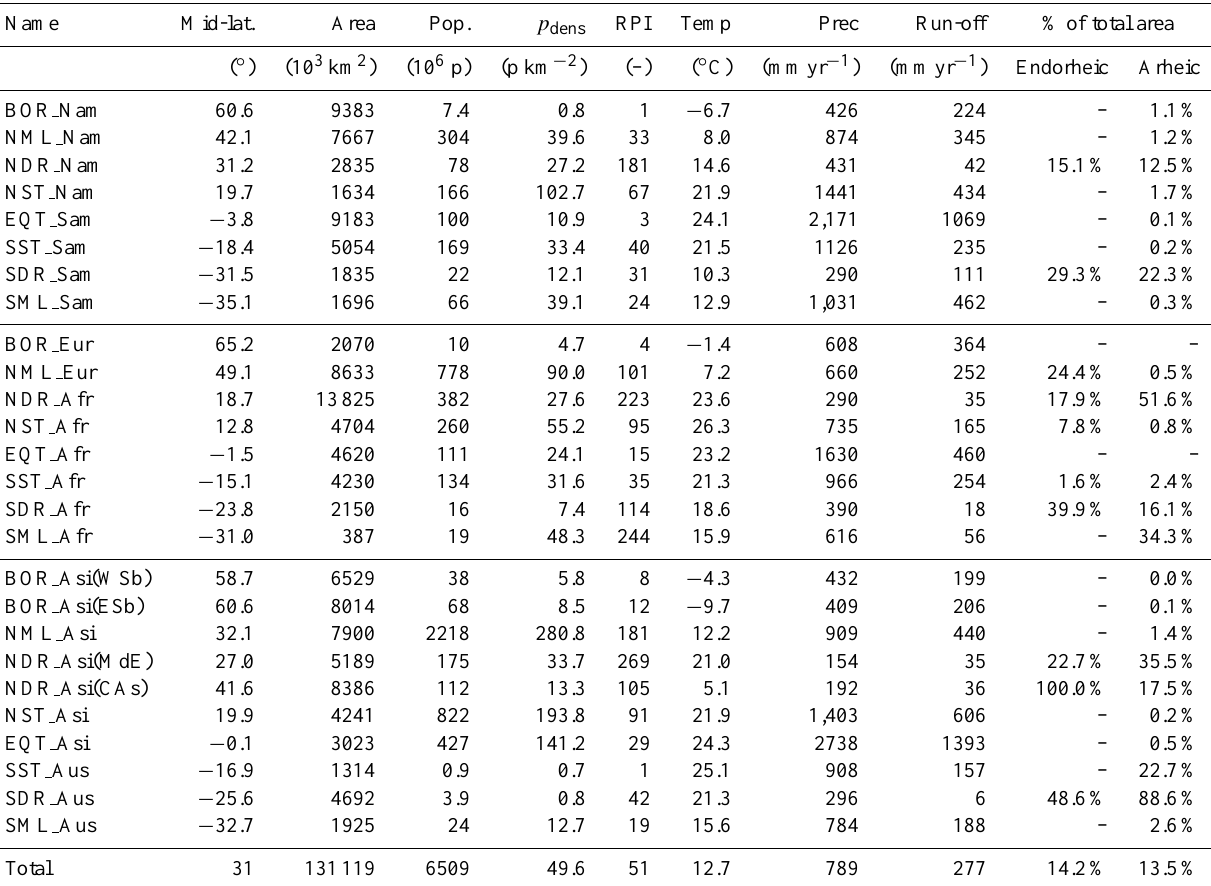
Table 4. General average characteristics of hydroregions (area weighted averages and totals) presented in three north–south profiles. BOR = boreal, NML = northern mid-latitude, NDR = northern dry, NST = northern subtropical, EQT = equatorial belts and SML, SDR, SST their southern analogues; North America (NAm), South America (SAm), Europe (Eur), Africa (Afr), Asia (Asi) and Australia (Aus). RPI stands for relative pressure indicator = ( d pop / q ) hydroregion/( d pop / q ) N. Am boreal region. See Fig. 2 for the spatial distribution of hydroregions and Table 2 for data sources (see Sect.